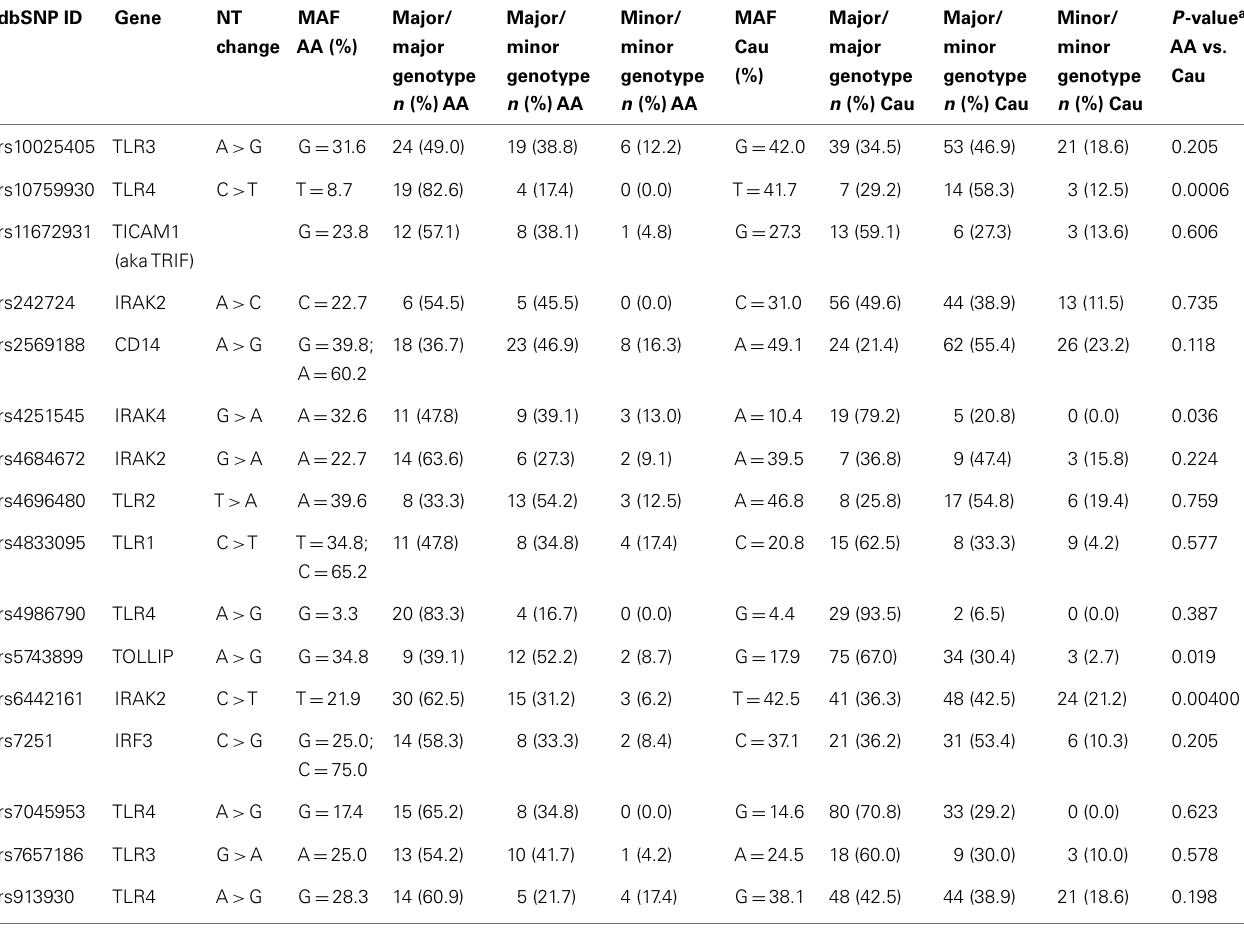
Table 1 | Prevalence of selected innate immunity sequence variants and their functional